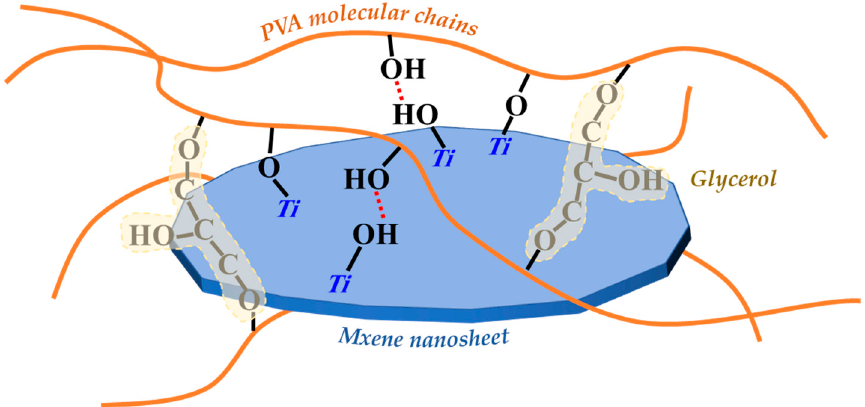
Figure 8. Schematic diagram of the crosslinking of PVA molecular chains, GC molecules and MXene nanosheets.